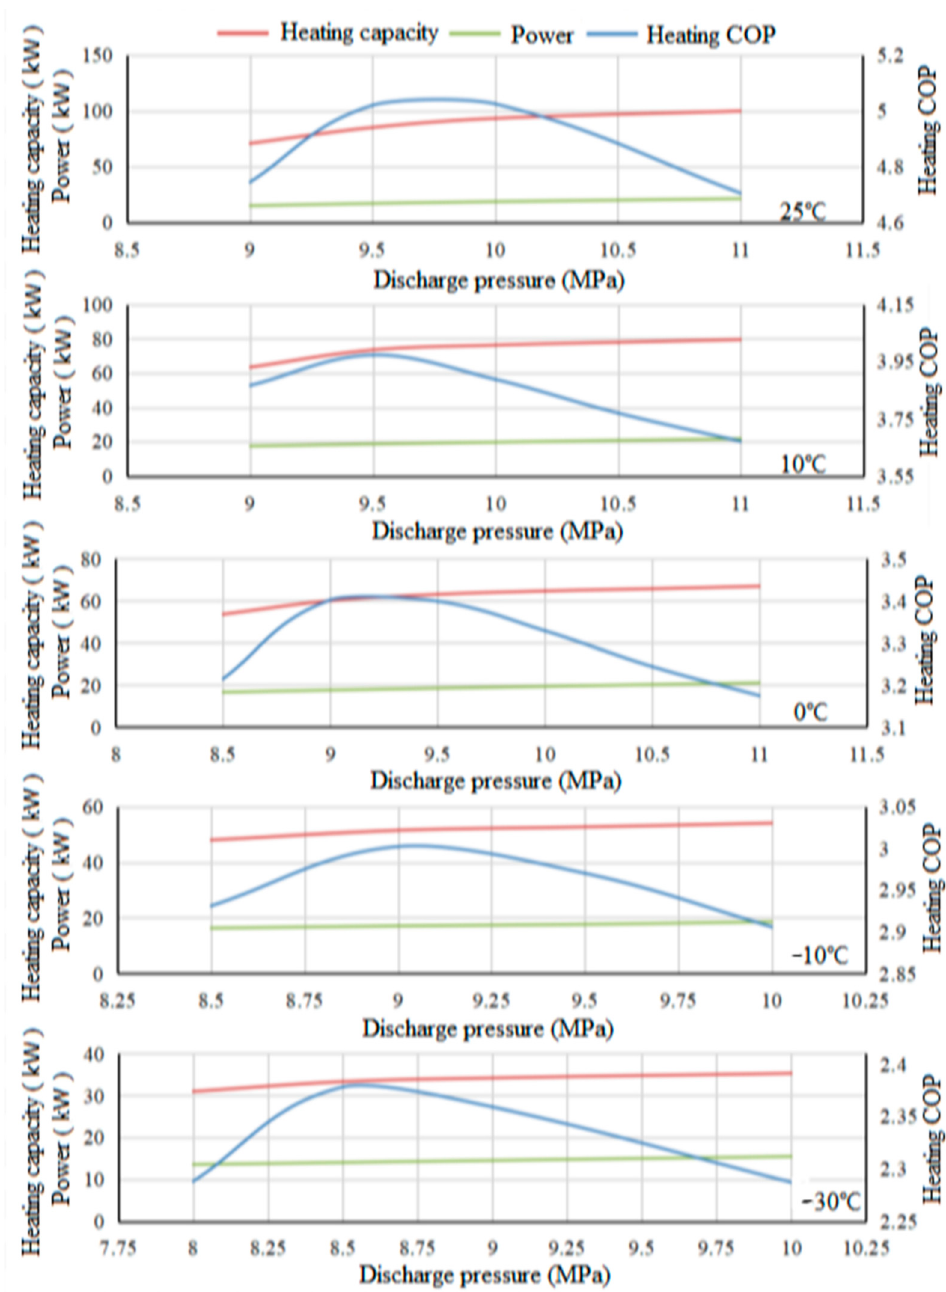
Figure 3. The sketch map of the optimal discharge pressure in the transcritical CO 2 systems.